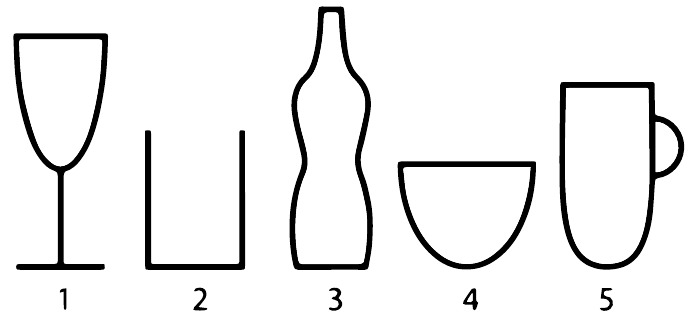
Figure 1. Shapes of drinking